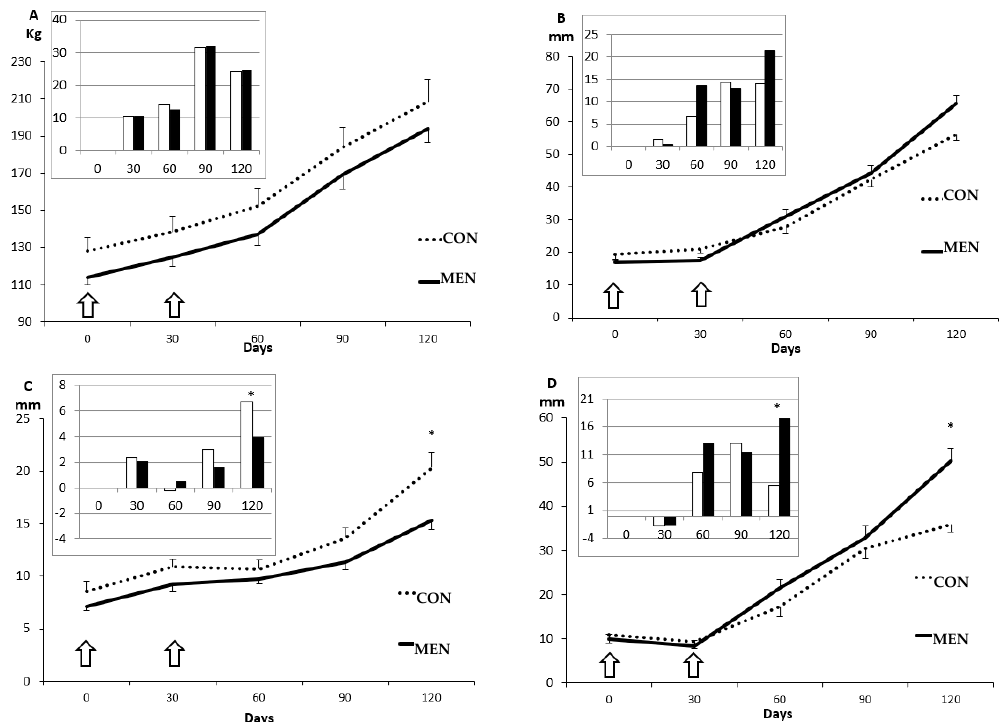
Figure 2. Mean values (± S.E.M.), over time of study, of body mass (panel A ) and depth of total (panel B ) and outer and inner layers (panels C and D ) of subcutaneous backfat depots in sows used as controls (discontinuous line) or treated with two doses of Vacsincel ® for inducing ovarian inactivity (continuous line; arrows indicate timing of treatment). The inset graphs represent the relative increases when compared to the previous assessment (white group CON, black group MEN); units are the same than in the main graph. Asterisks indicate significant differences between groups (* p < 0.05).